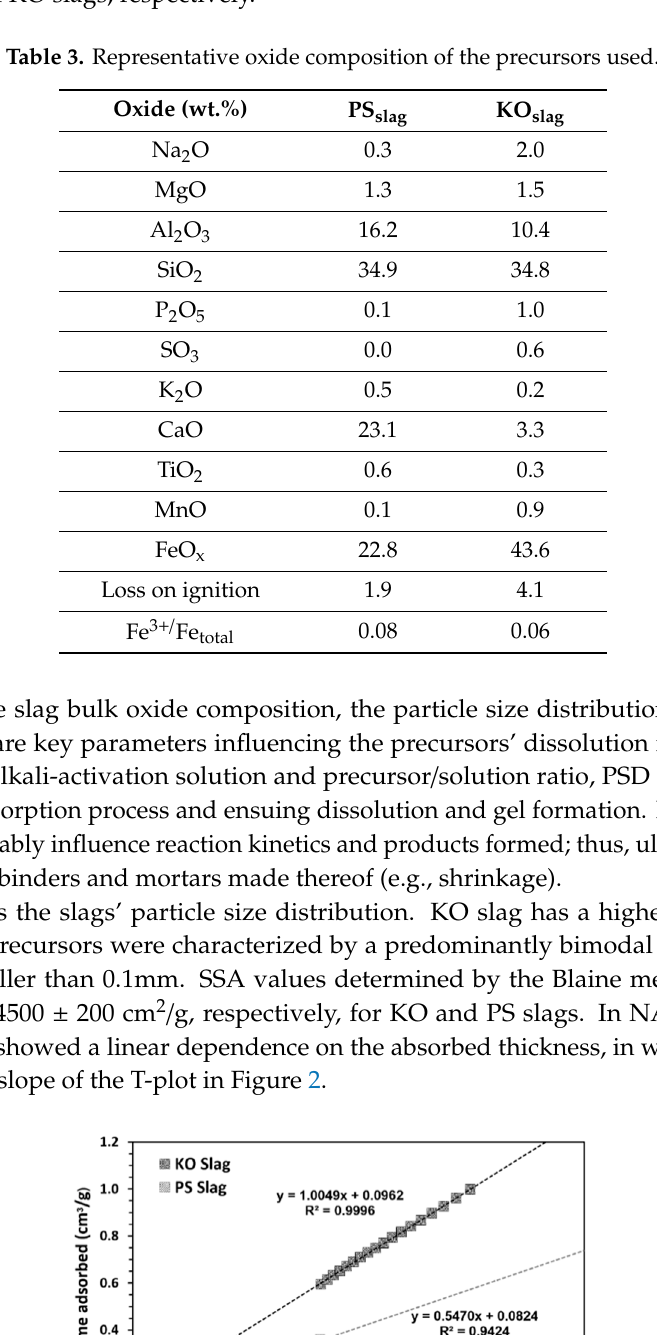
Table 3. Representative oxide composition of the precursors used.